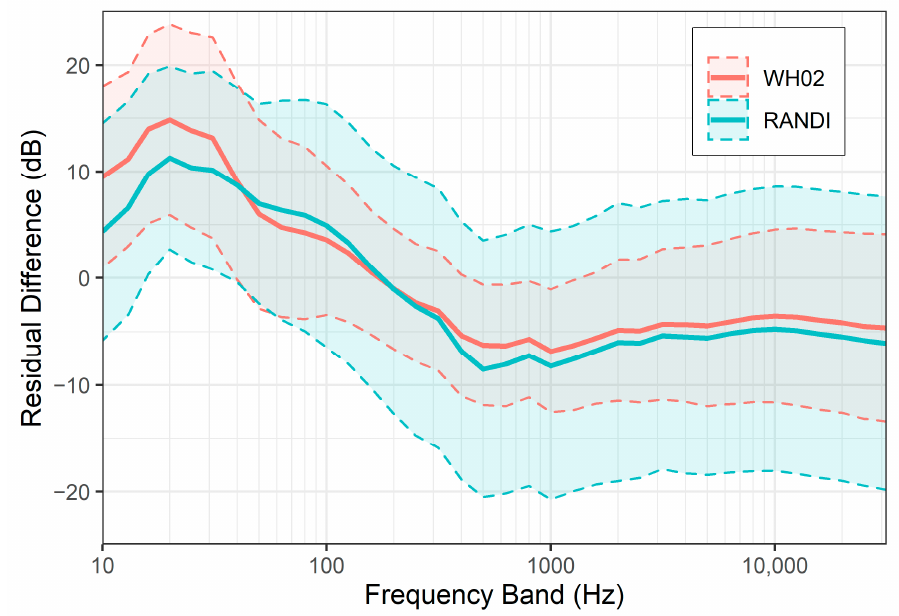
Figure 1. Mean residual differences (solid lines RANDI and WH02) versus frequency between the source level models and the ECHO data set. The dashed lines show the standard deviation of the residual differences about the mean.